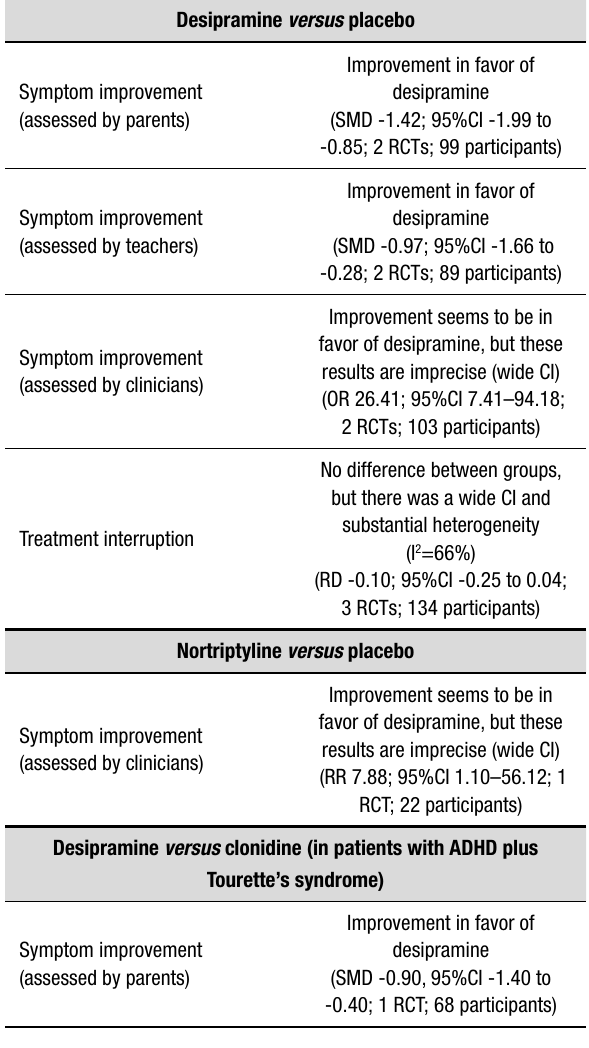
Table 4. Summary of the main outcomes: polyunsaturated fatty acids for attention deficit hyperactivity disorder.